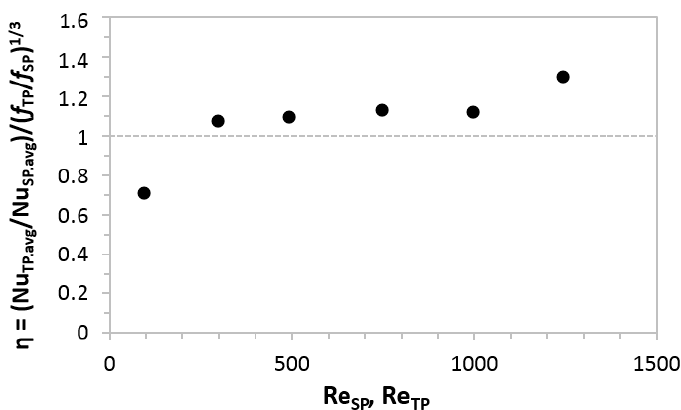
Figure 14. Dependence of the thermal performance criteria η on the Reynolds number ( Re SP , Re TP = 100–1250, at ϕ = 10% for two-phase flow).